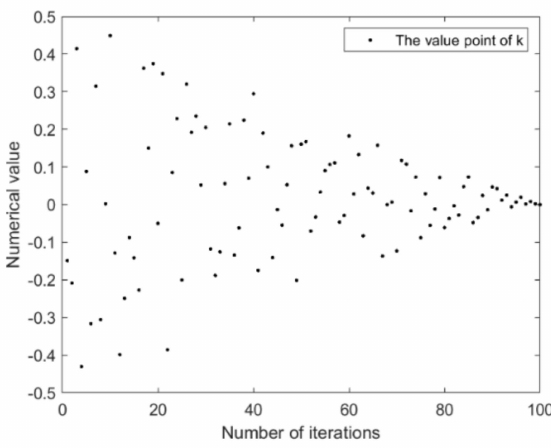
Figure 13. Variation of k with increasing number of iterations.